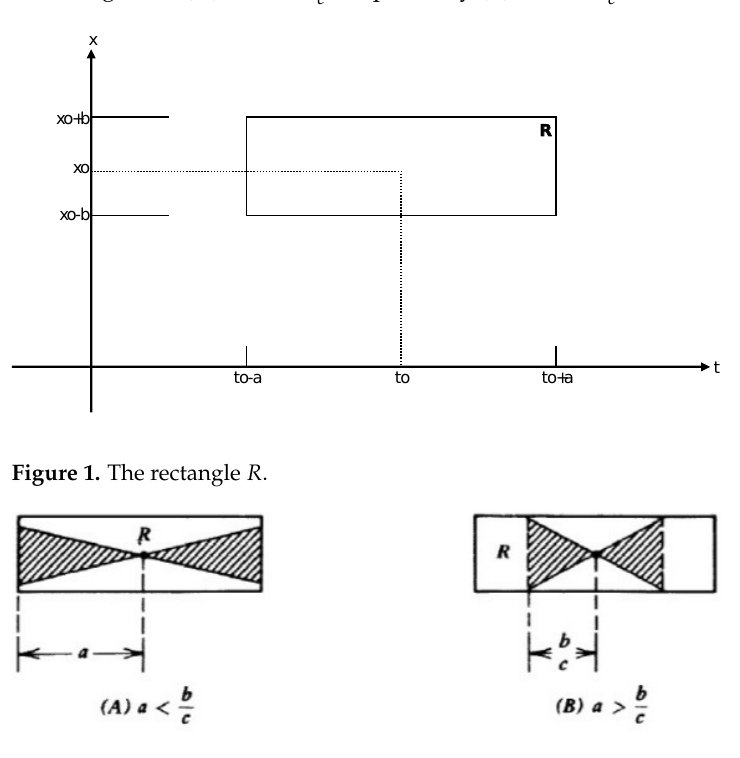
Figure 2. Graphical representation of |S ( t , X ) | ≤ c